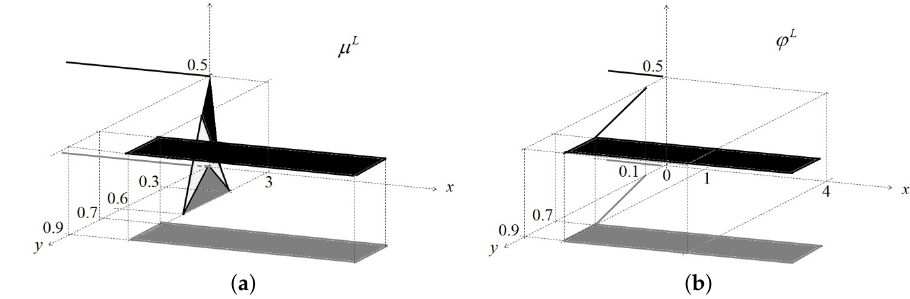
Figure 9. ( a ) µ L and ( b ) ϕ L according to Example 3.